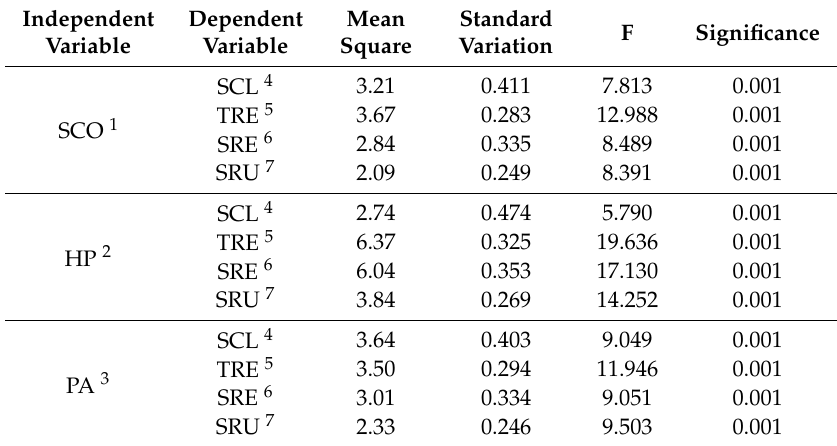
Table 4. Comparison of Mean between Physical Self-Content and School Adjustment. Independent Variable